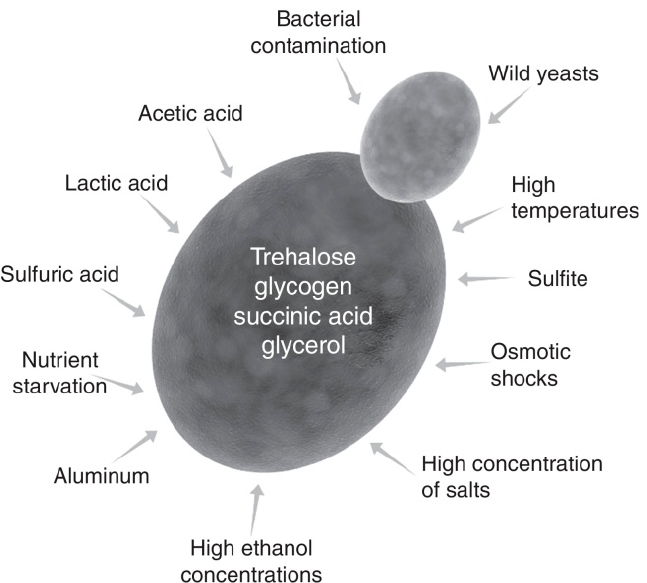
Figure 1. Main stress factors affecting yeast cells in industrial fermentations for ethanol production and response mechanisms commonly involved (reproduced from Lopes et al.